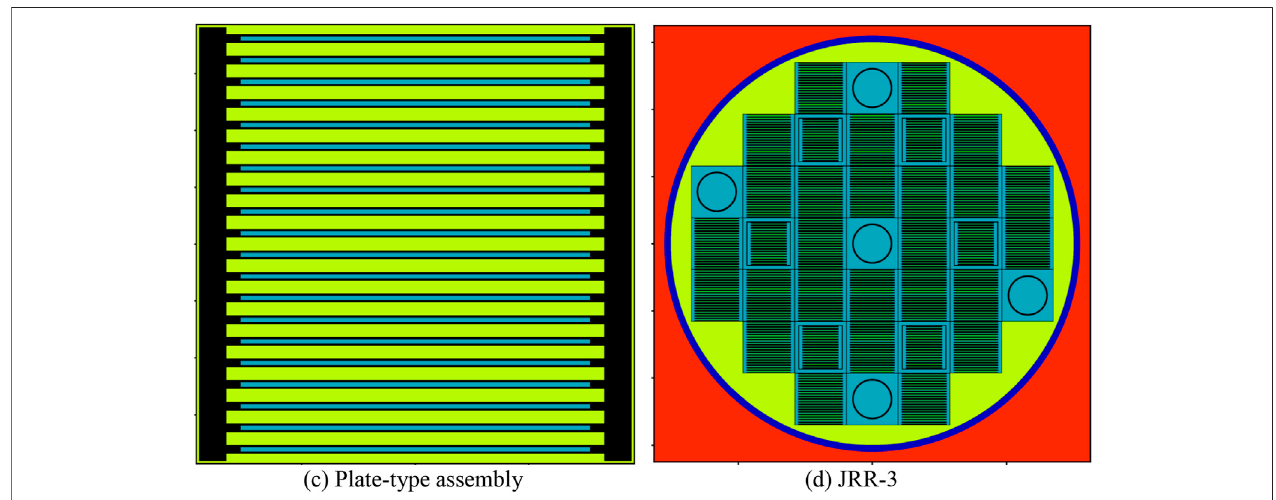
FIGURE 2 | Complicated geometry modeling of SHARK.